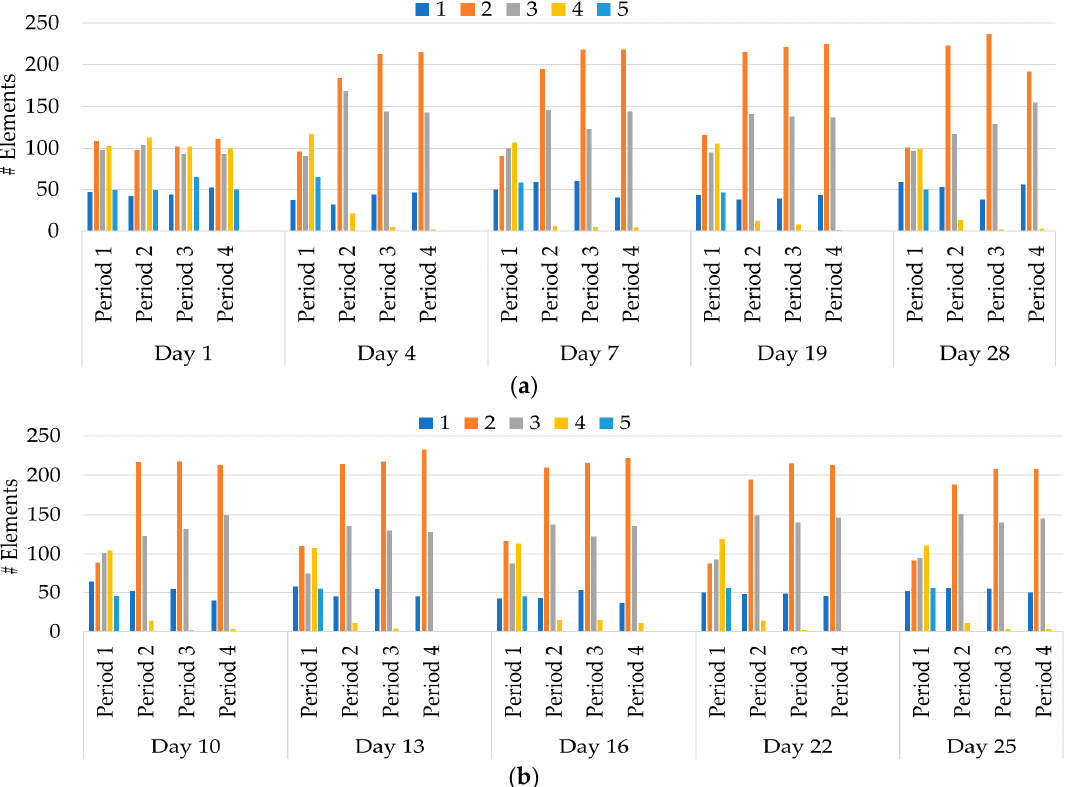
Figure 6. Number of elements per Reliability Rate group considering the initial rate being: ( a ) DR event 1; ( b ) DR event 2.